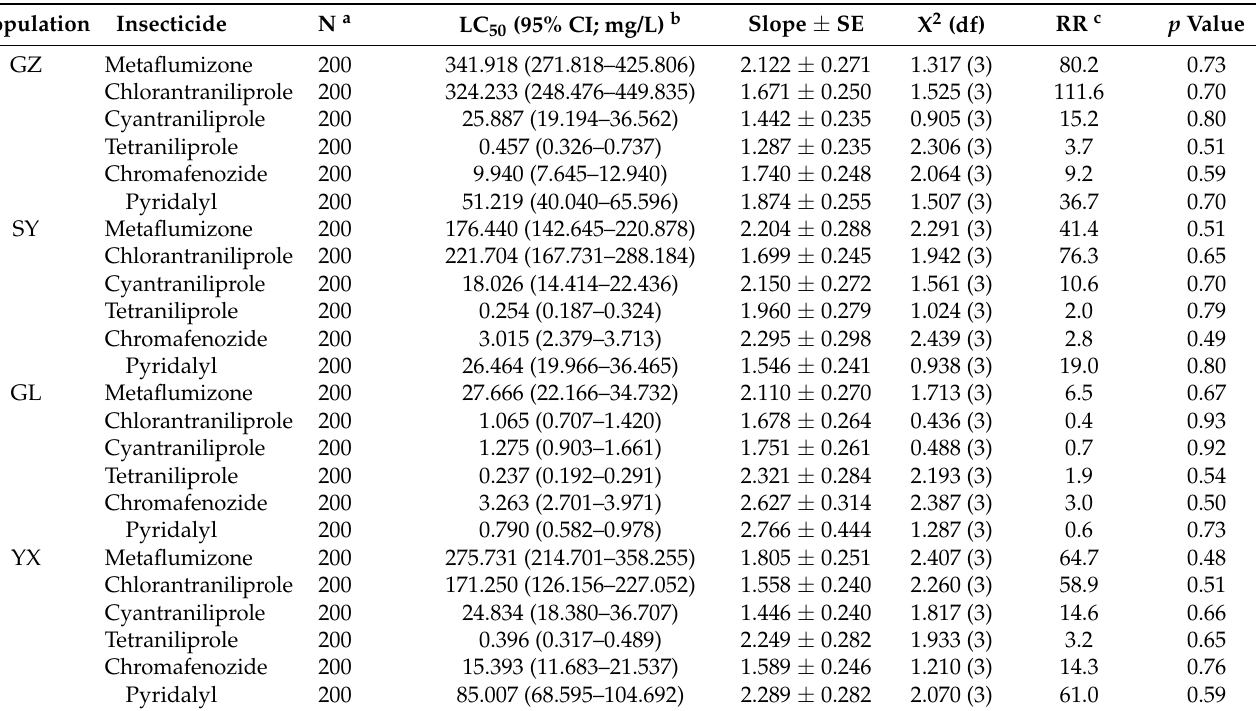
Table 6. Insecticide susceptibility of S. litura collected from southern